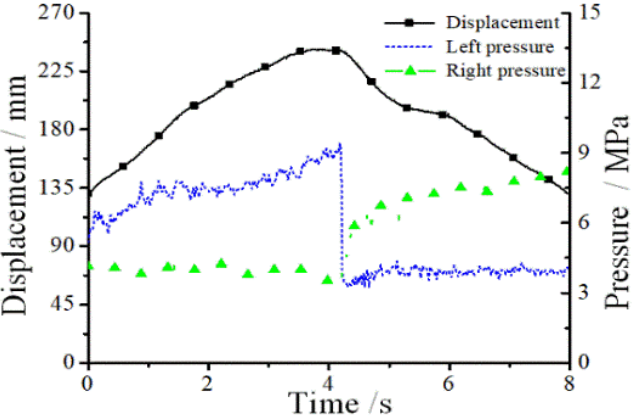
Figure 12. Test curves of the steering with offset load.